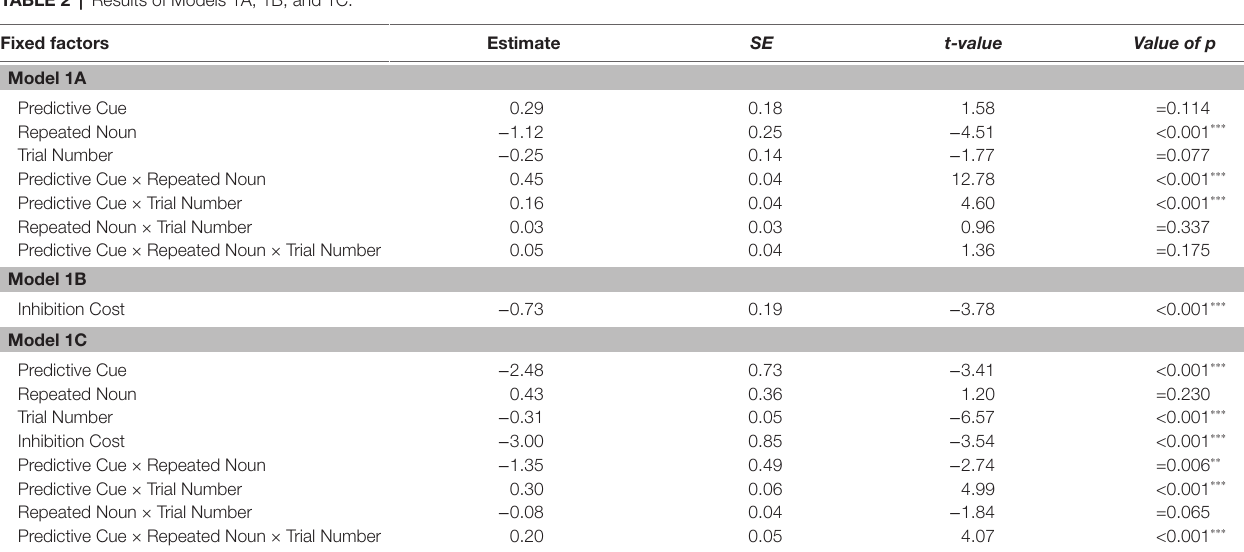
TABLE 2 | Results of Models 1A, 1B, and